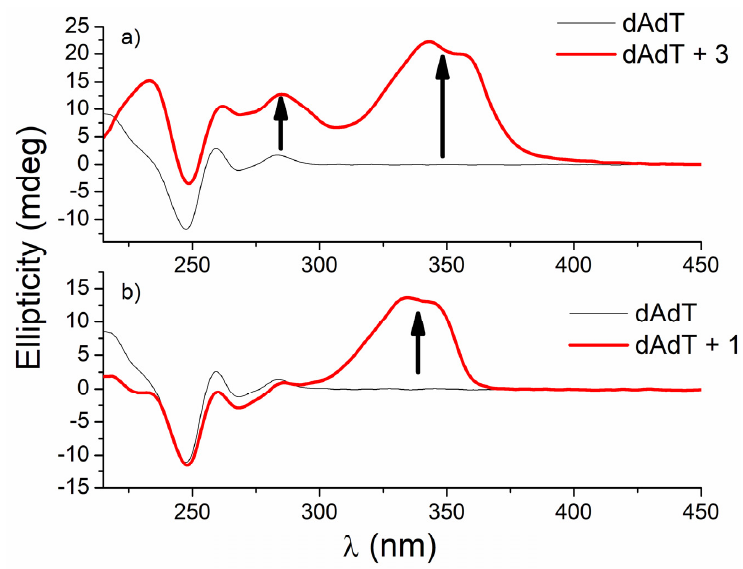
Figure 9. CD titrations of AT-DNA duplex (dAdT) ( c = 3.0 × 10 − 5 mol dm − 3 ) with 3 ( a ) and 1 ( b ) at molar ratios r = [compound]/[polynucleotide] = 0.4 and 0.1, respectively (pH = 7.0, buffer sodium cacodylate, I = 0.05 mol dm − 3 + 1 mM EDTA).